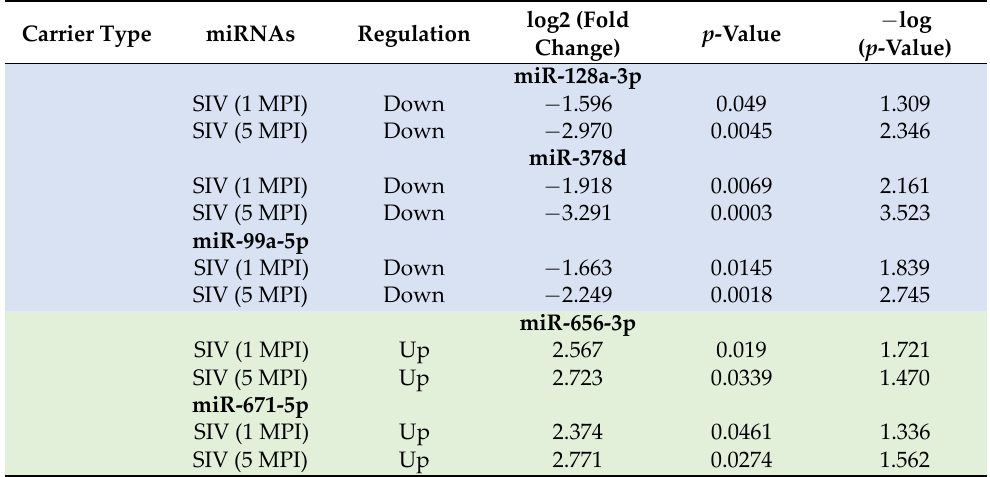
Table 4. Longitudinally regulated EV‑ and EC‑associated miRNAs by